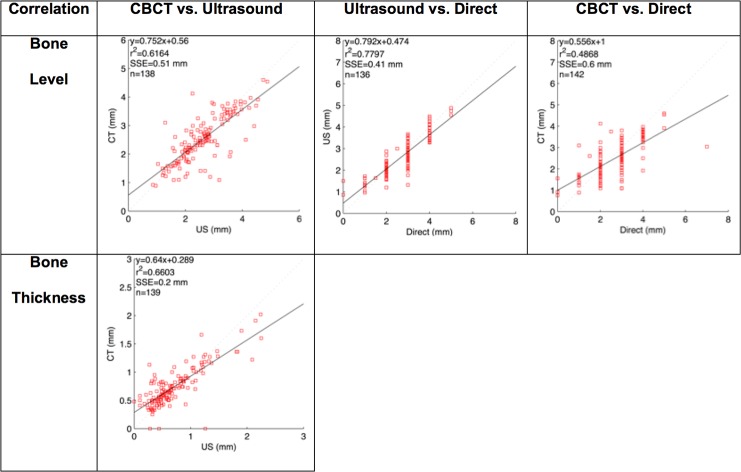
Correlations of bone level and thickness readings between 3 estimation methods.